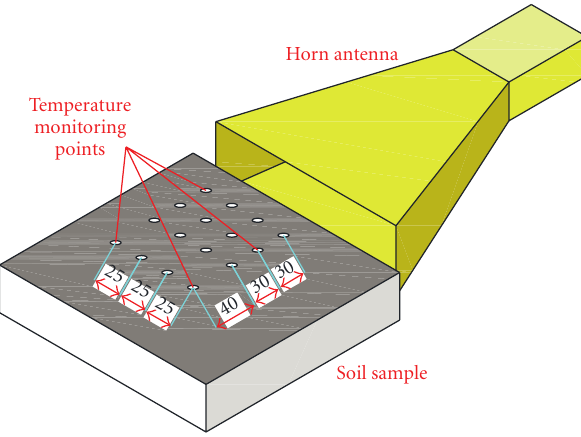
Figure 13: Schematic of thermometer placement during tempera- ture measurement